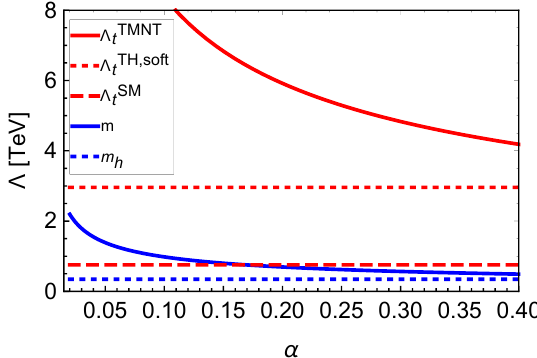
Figure 2 . Natural values for the top sector cuto(cid:11) (cid:3) t and radial modes in the TMNT model, the softly-broken Twin Higgs model, and the Standard Model as a function of (cid:11) (cid:17) (cid:22) (cid:20) red line, dotted red line, and dashed red line denote the respective top sector cuto(cid:11) scale in each model corresponding to no tuning of the Higgs mass. The natural values for the Higgs quartic cuto(cid:11) are comparable in each model | (cid:24) 2 TeV | and are not shown here. The solid blue line and dotted blue line denote the tree-level mass parameters m and m h of the TMNT and softly-broken Twin Higgs, respectively, which are proxies for the scale of new radial modes. Here we have taken (cid:20) 1 = (cid:20) = 0 : 065 ; (cid:22) (cid:21) = 0 : 8 ; (cid:21) = 1 : 0 ; y t = 0 :